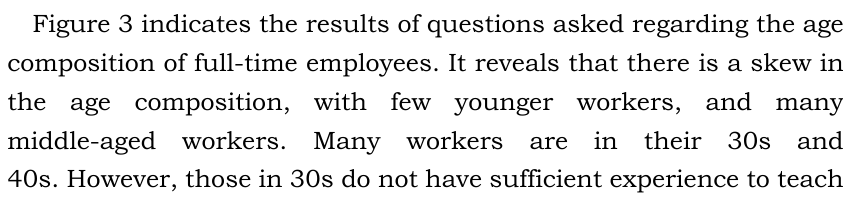
2013, there were 582 full-time employees, 111 contract-based workers , 47 temporary workers, 28 fixed-term (one year or longer) employees, 12 fixed-term (less than one year) employees, and four part-time employees.